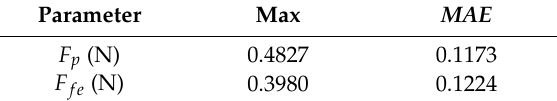
Figure 9. The objects used in the experiment of ILC. Table 3. The ILC quality parameters in the experiment.